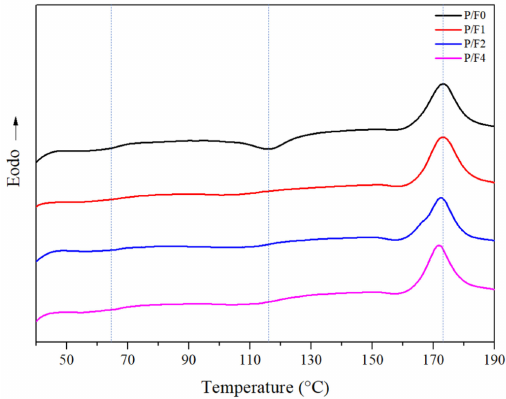
Figure 8. DSC second heating curves of P/F